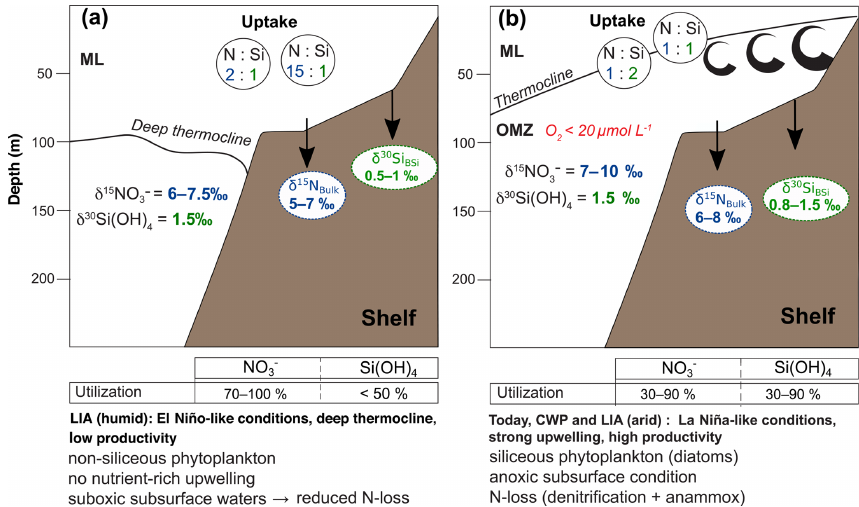
Figure 7. Schematic nutrient (Si ( OH ) 4 and NO − the shelf area (0–200m water depth) during the last 600 years. The NO − taken up during biological production in surface